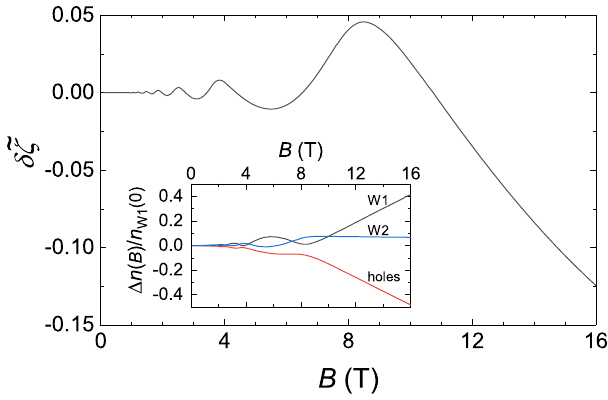
Fig. 4 The fi eld-induced shift of the chemical potential relative to its value ζ 0 ≡ ζ (0) at zero magnetic fi eld in TaAs. Shown is the normalized shift δ ~ ζ (cid:4) ð ζ ð B Þ (cid:2) ζ 0 Þ = ð ζ 0 (cid:2) ε W 1 Þ that is calculated together with the dashed black line in Fig. 3. Inset: Dependences of ( n W 1 ( B ) − n W 1 (0))/ n B ) − n n n B ) − n n B . Note n W 1 (0), ( W 2 ( W 2 (0))/ W 1 (0), and ( h ( h (0))/ W 1 (0) on that although δ ~ ζ decreases with increasing fi eld above 8.5 T, n w 1 ( B ) simultaneously increases due to the growing capacity of the Landau levels.